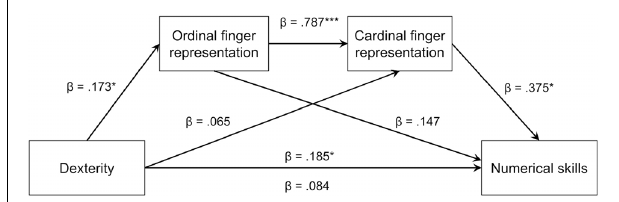
FIGURE 2 | Results of the mediation model for the association between dexterity, finger-based number representations and numerical skills.